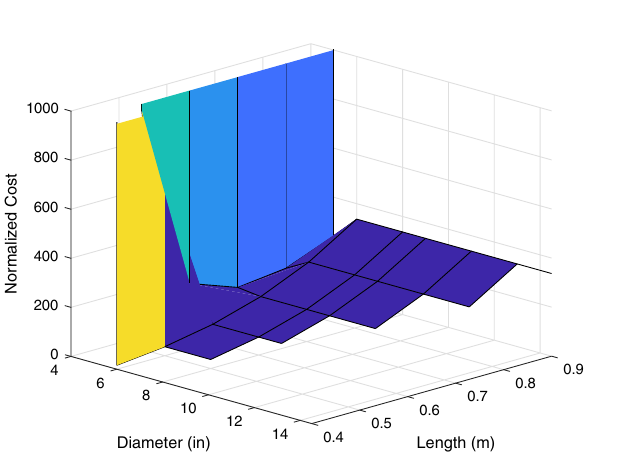
Figure 5. The cost surface shows that for propeller diameters below a certain threshold, the system becomes unstable, resulting in extremely high cost 32 .